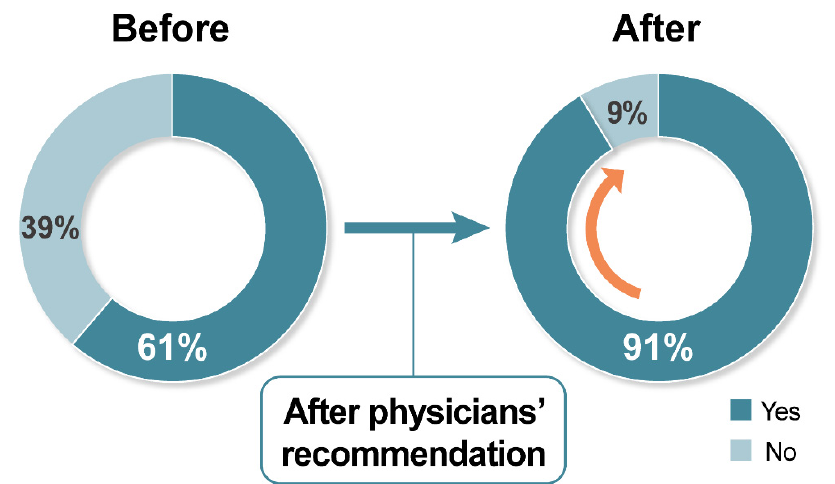
Figure 4. Changes in cancer patients’ acceptance rate for COVID-19 vaccination after physicians’ recommendations.